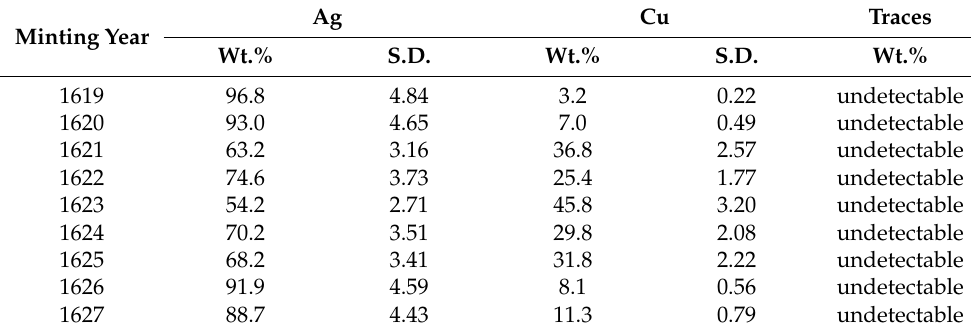
Table 3. Elemental compositions of the investigated 3-Polker coins.